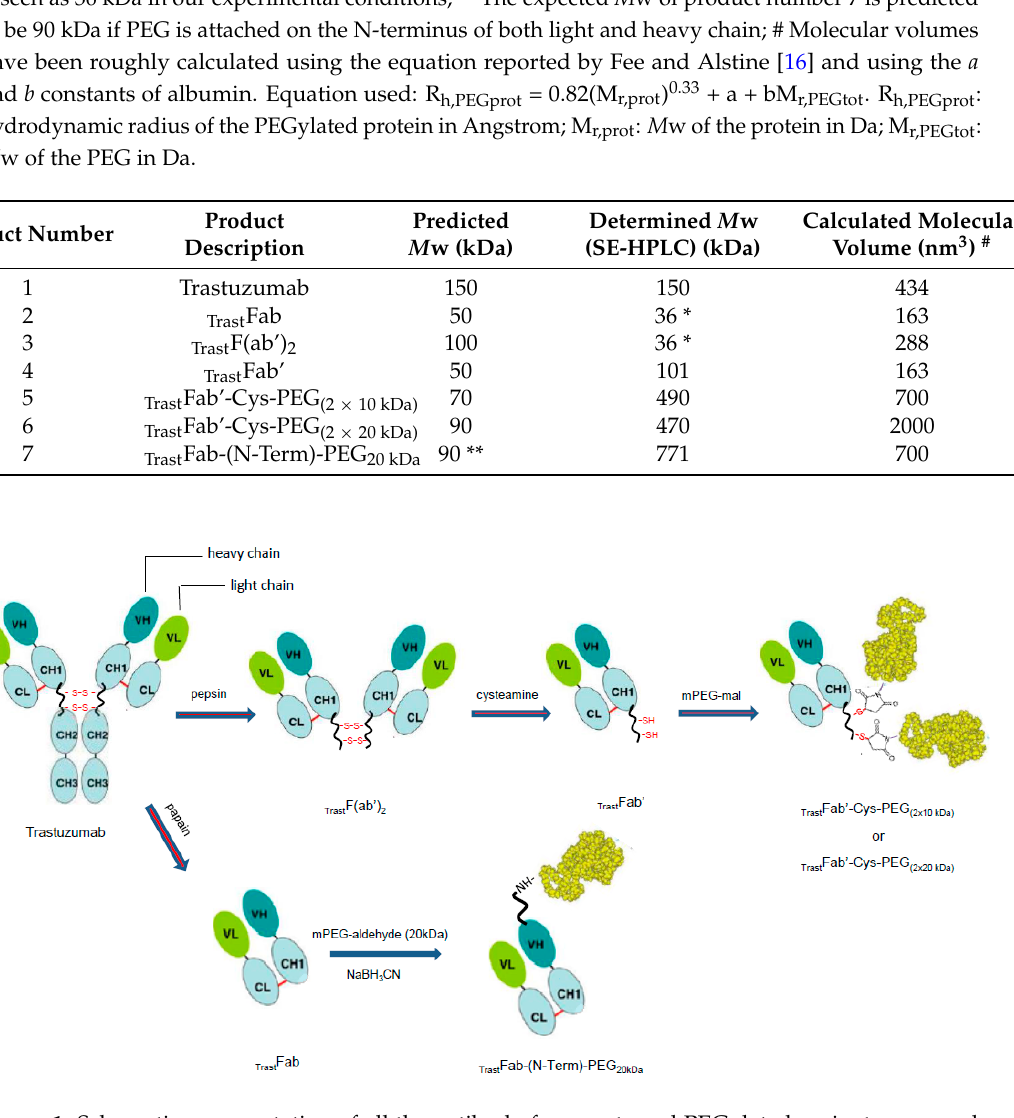
Figure 1. Schematic representation of all the antibody fragments and PEGylated variants prepared starting from Trastuzumab, reported as Trast F(ab’) 2 , Trast Fab’, Trast Fab, Trast Fab’–Cys–PEG (2 × 10 kDa) , Trast Fab’–Cys–PEG (2 × 20 kDa) and Trast Fab–(N-Term)–PEG 20 kDa . VH and VL are variable domains of the antibody heavy and light chain respectively; CL is the constant domain of the antibody light chain; CH1, CH2 and CH3 are the constant domains of the antibody heavy chain.